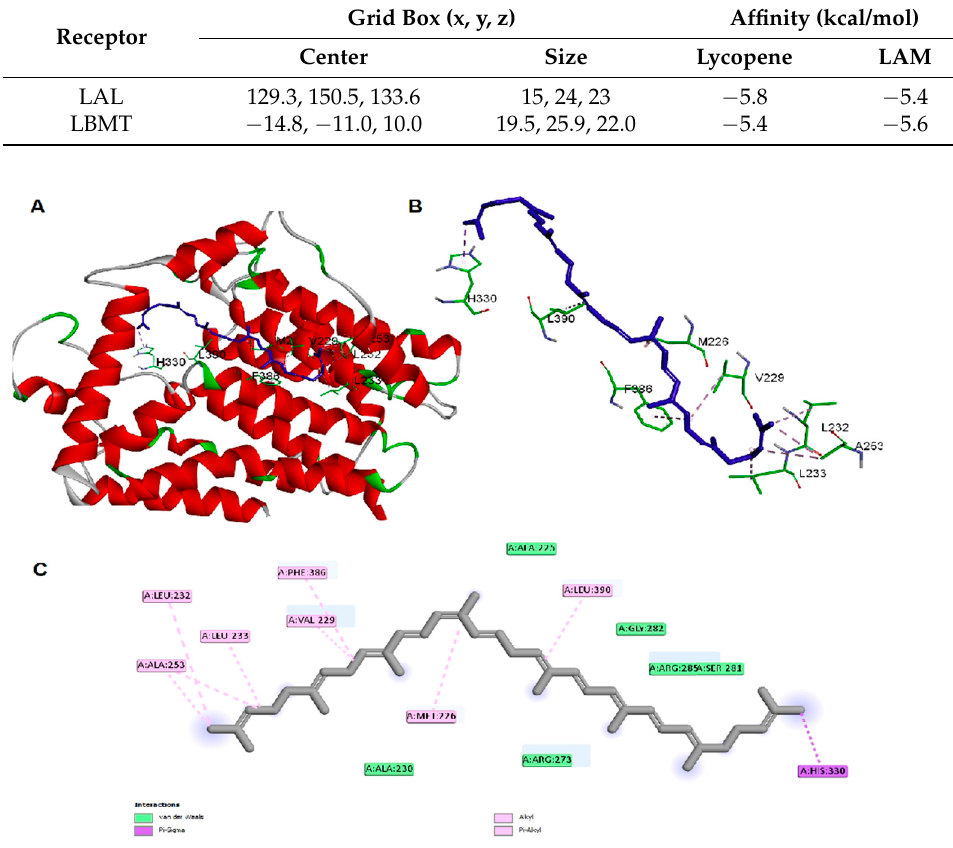
Figure 3. Docking of lycopene in K. pneumoniae lipid A core-O-antigen ligase (LAL) ( A ) whole protein view ( B ) active site view, and ( C ) the 2D schematic presentation of interaction forces. After all, both lycopene and LAM showed a good affinity for the studied proteins enrolled in the production of capsule lipopolysaccharide of K. pneumoniae suggesting the possible mechanisms for the antibacterial activity of